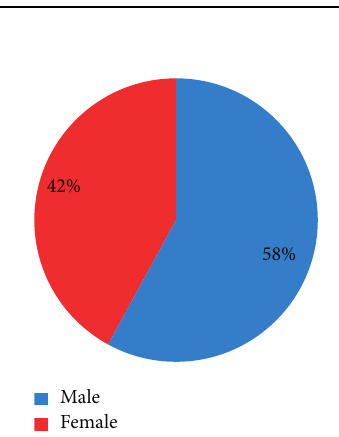
Figure 2: Gender distribution of the